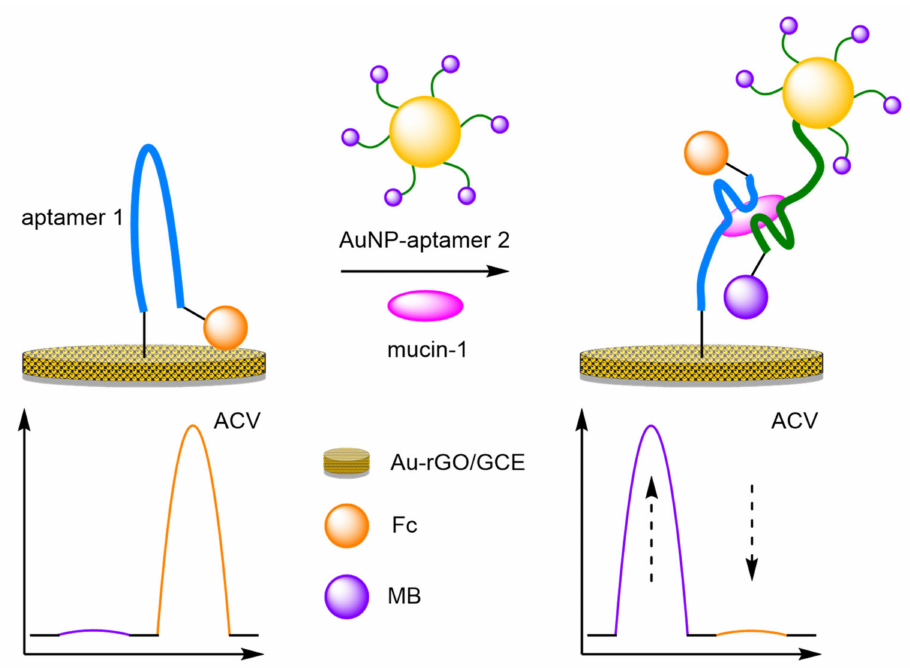
Figure 22. Schematic representation of a nanoparticles-assisted label amplification biosensor.